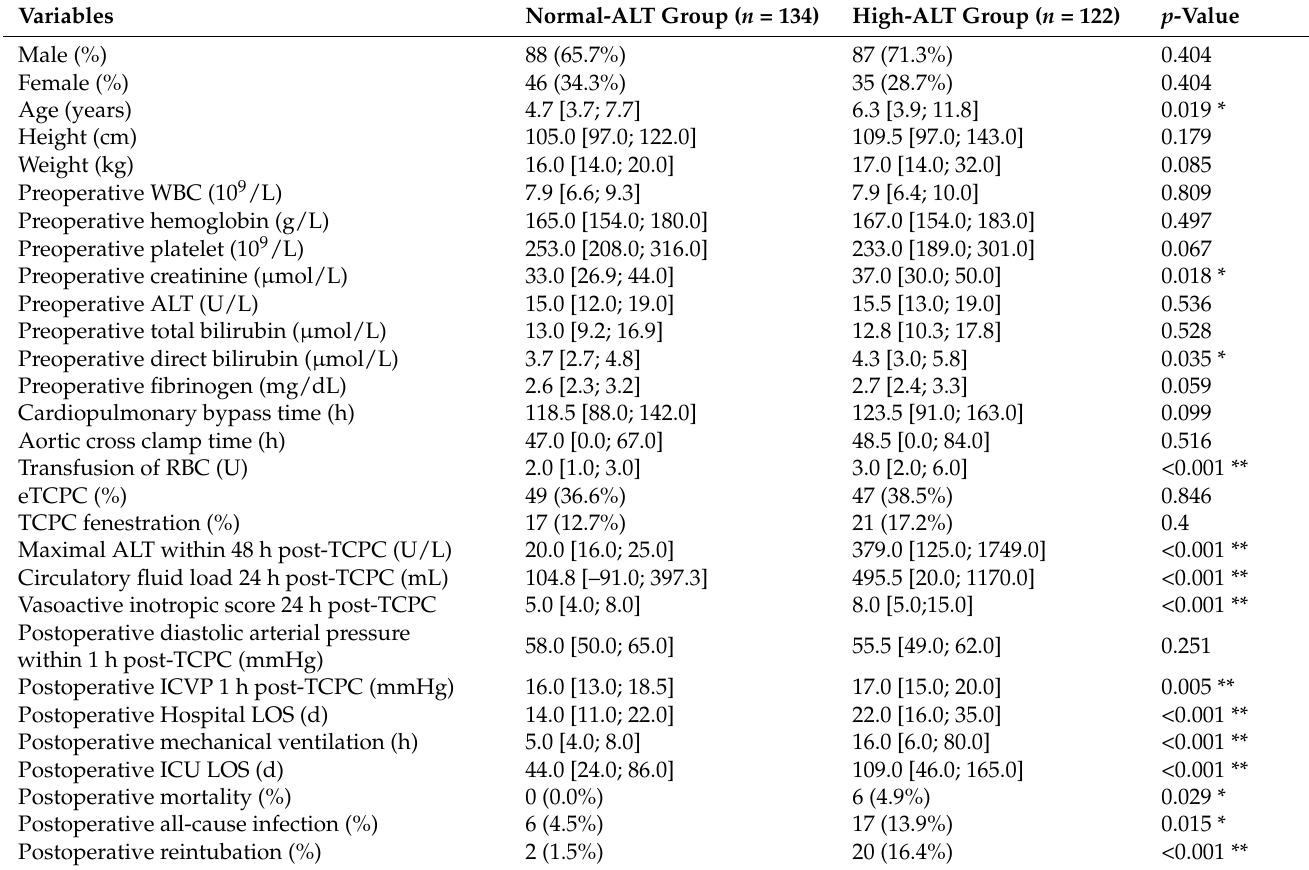
Table 1. Clinical characteristics of subjects stratified by maximal ALT value within 48 h post TCPC.